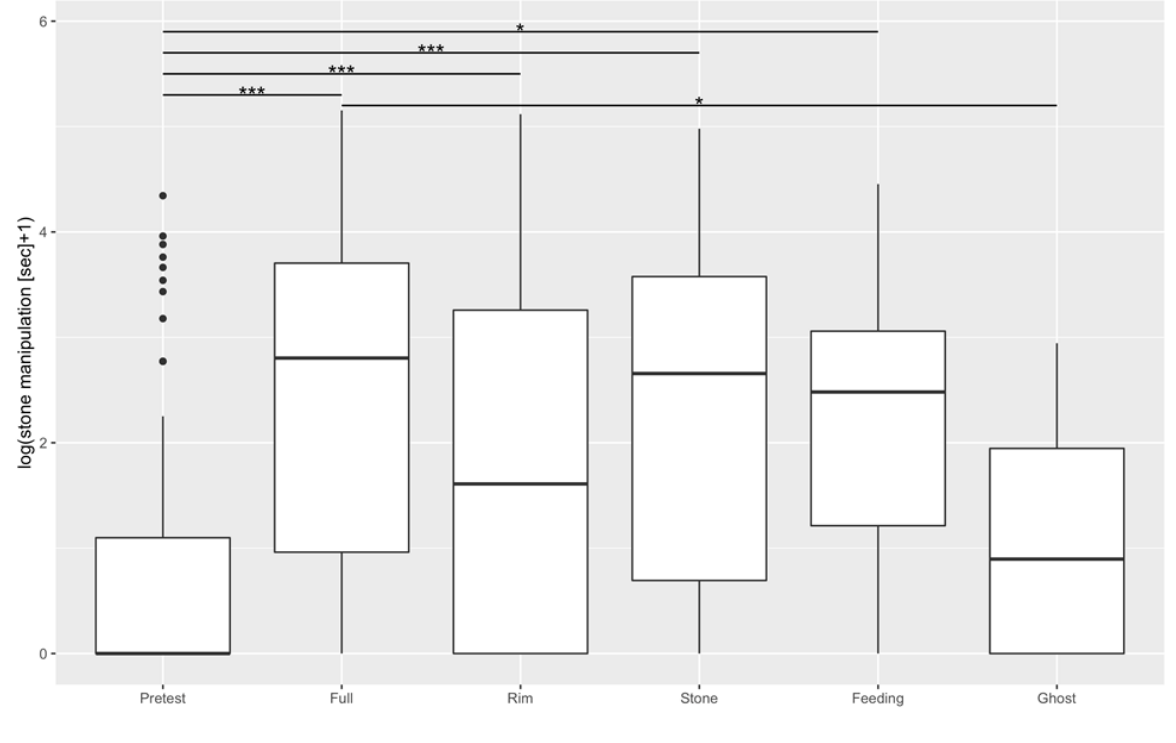
Stone Manipulation Time (log seconds) for each Experimental